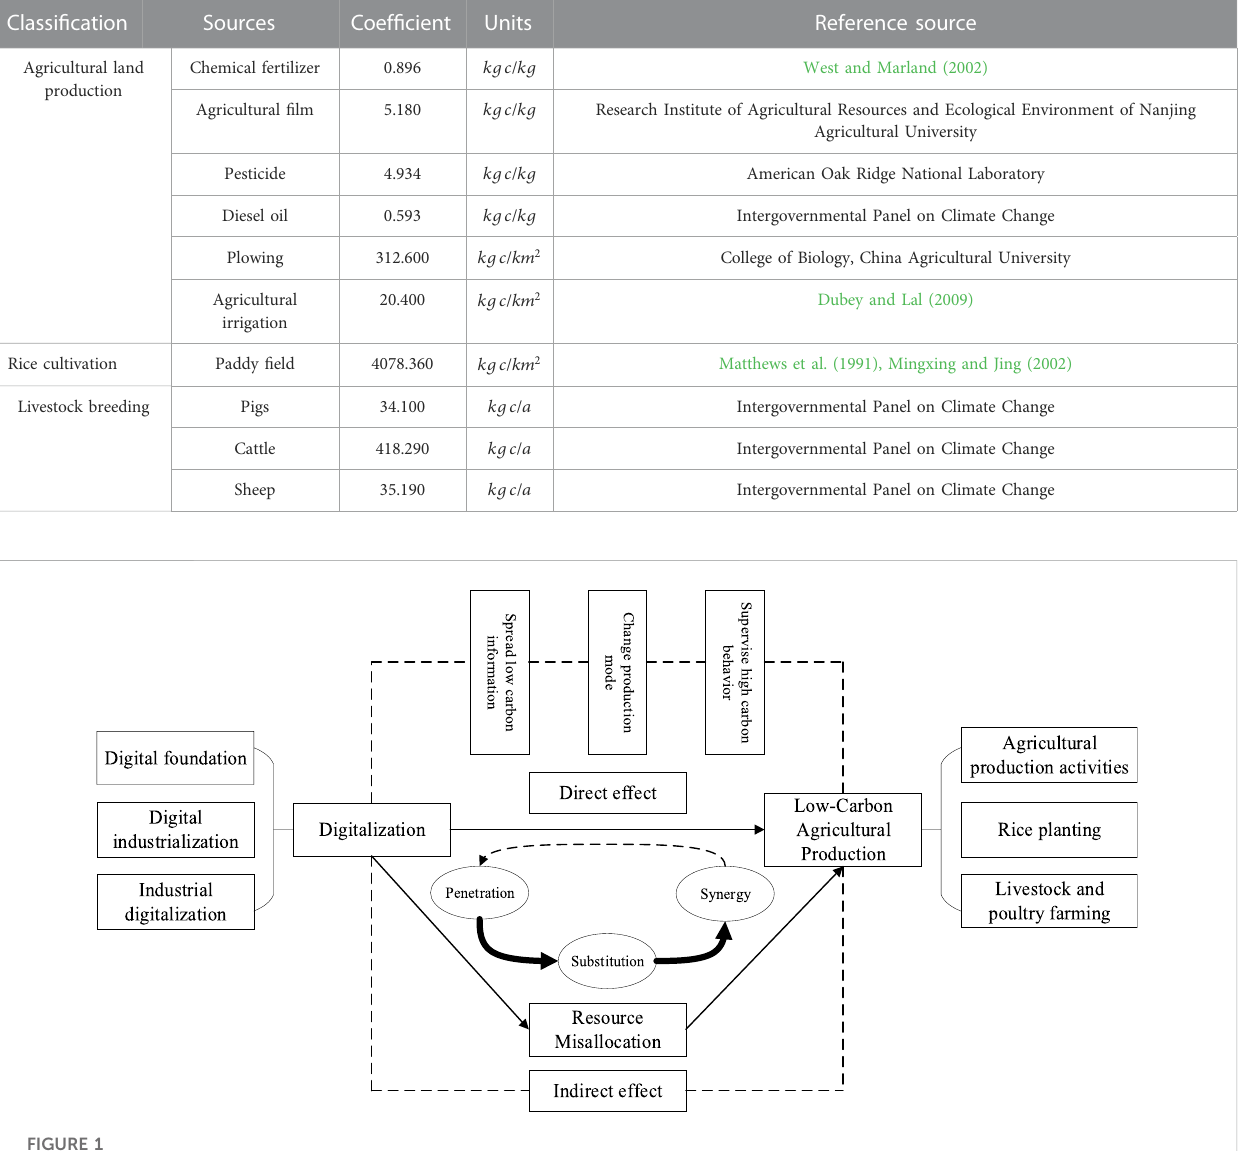
FIGURE 1 The impact mechanism of digitalization on low-carbon agricultural